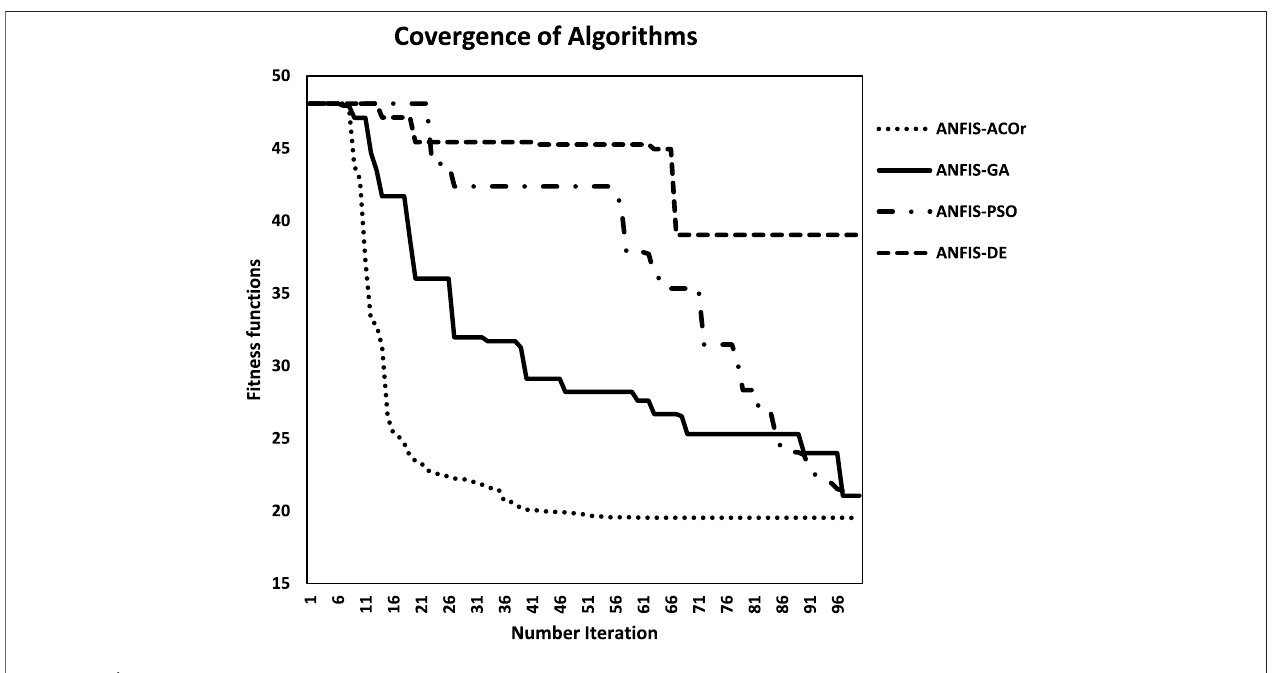
FIGURE 11 | The quality of simulating by proposed